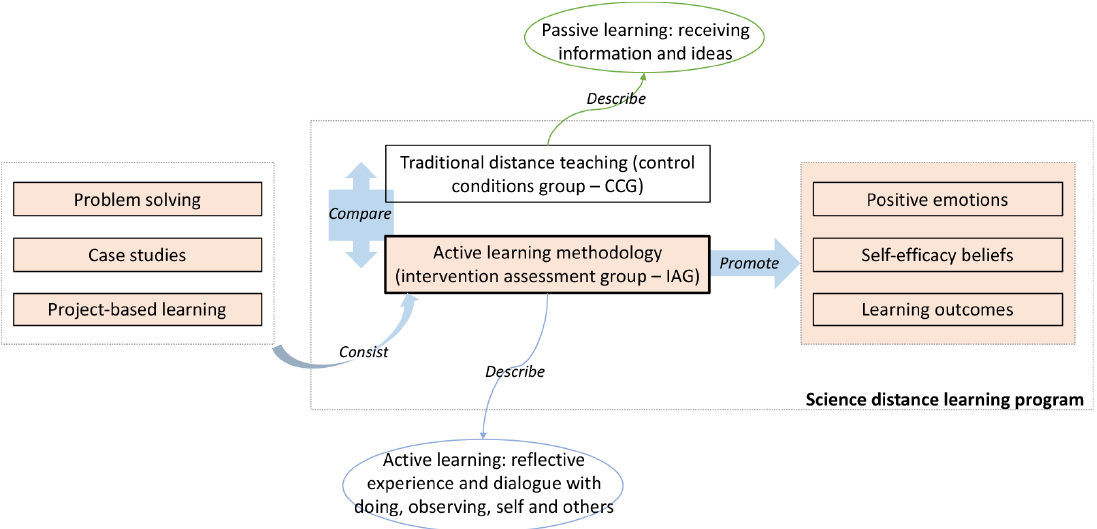
Figure 1. Process framework deployment of the study proposed, active learning activities’ methodology